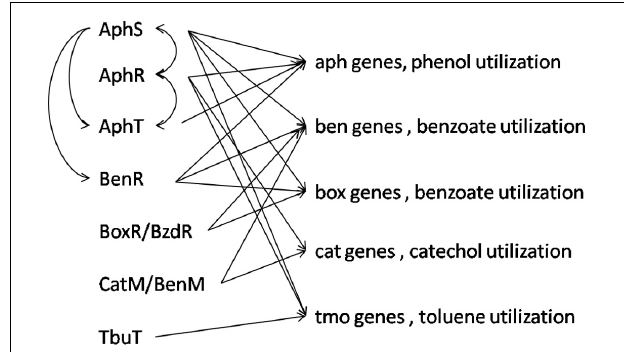
FIGURE 10 | Integrated scheme of interactions between aromatic metabolism TFs and regulated genes in all studied genomes.